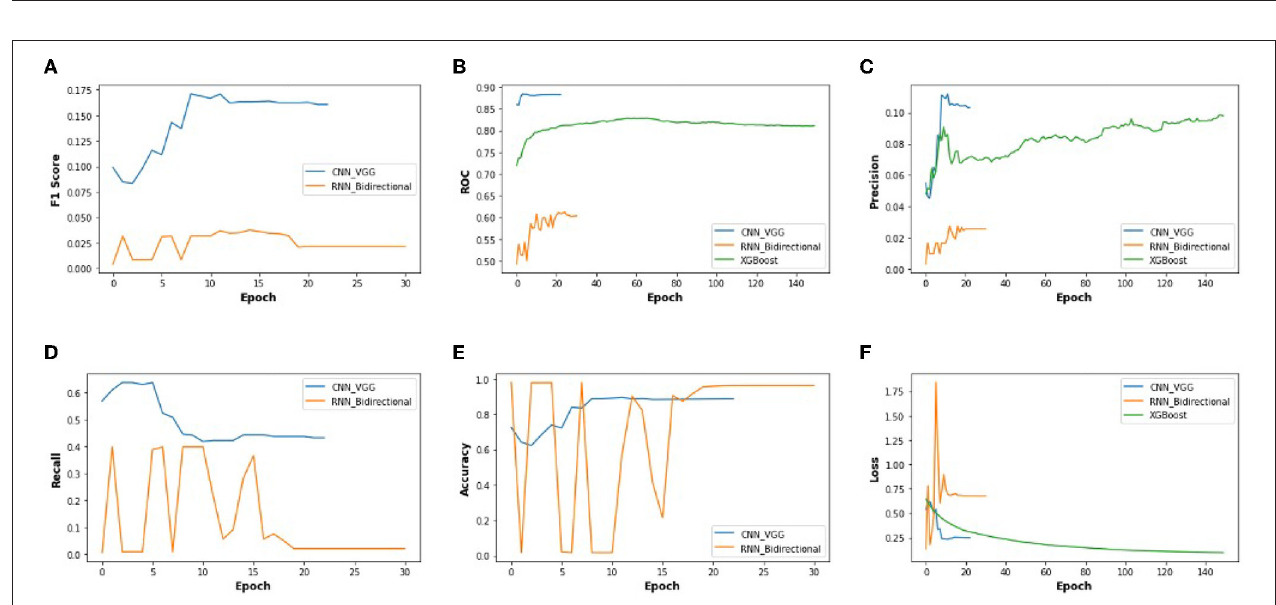
FIGURE 10 | The performance metrics of different architecture of CNN, RNN, and XG-Boost with the variable number of epochs (A) F1 score, (B) ROC, (C) Precision, (D) Recall, (E) Accuracy, and (F) Loss.